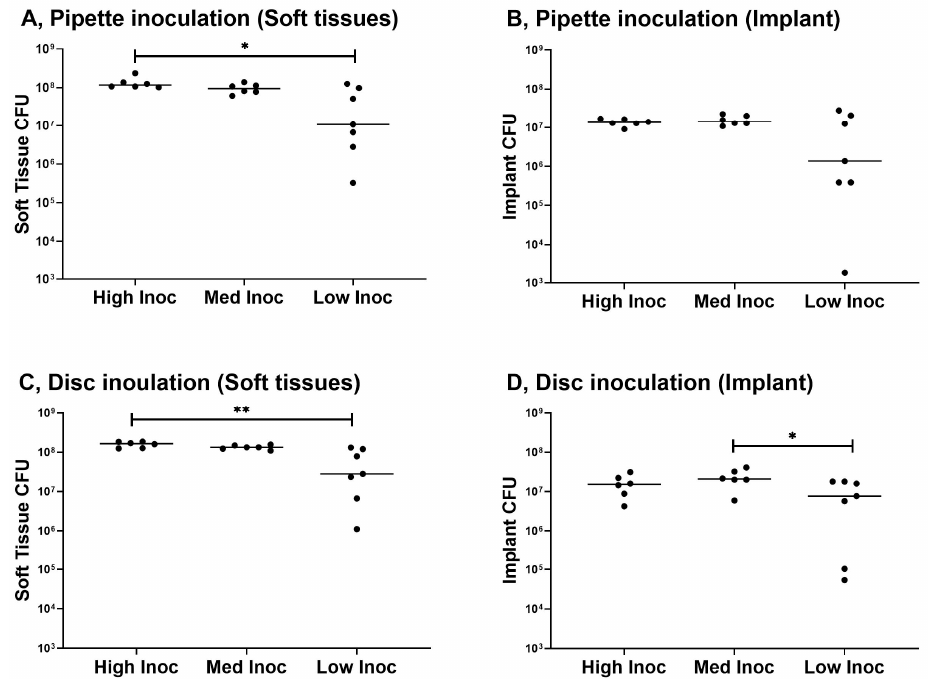
Figure 2. Results of dose-finding phase. Results are grouped according to the sample type and inoculation method for the high (n = 7), medium (n = 6) and low (n = 7) inoculum; ( A ) Pipette inoculation, soft tissue sample, * statistical significance between the high and low inoculum ( p = 0.02); ( B ) Pipette inoculation, implant sample; ( C ) Disc inoculation, soft tissue sample, ** statistical sig- nificance between the high and low inoculum ( p = 0.004); ( D ) Disc inoculation, implant sample, * statistical significance between the medium and low inoculum ( p = 0.05). The detected CFU count is displayed on the y -axis; the three utilized bacterial inocula are represented on the x